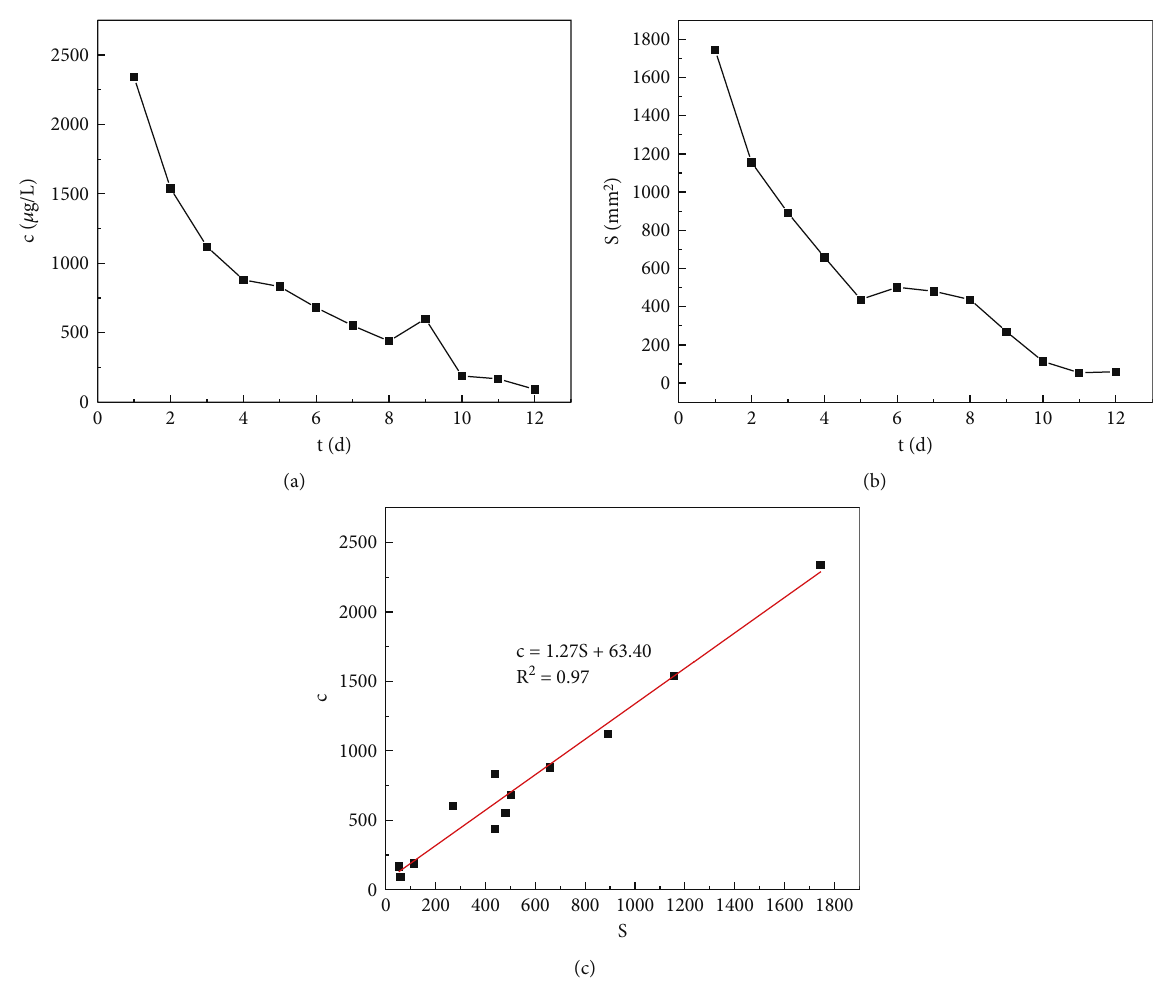
Figure 17: PCE concentration and area